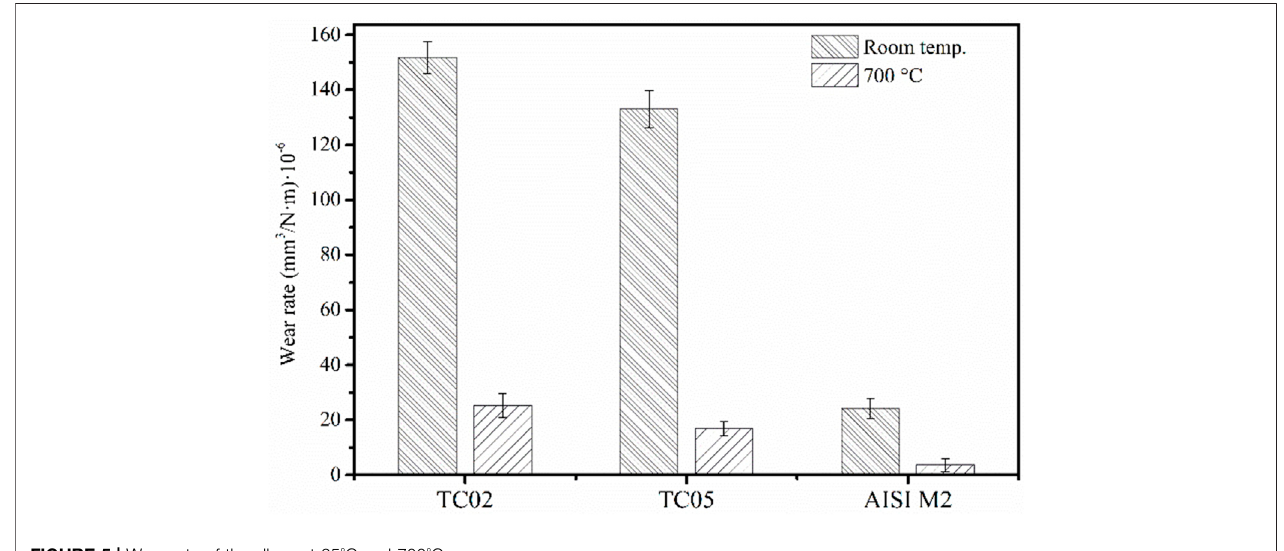
FIGURE 5 | Wear rate of the alloys at 25 ° C and 700 ° C.